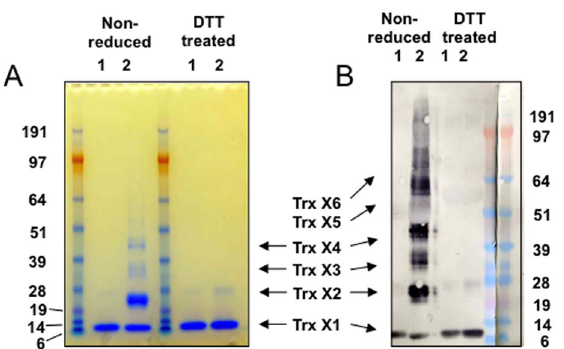
Figure 1. SDS-PAGE and Western blot analysis of recombinant human Trx1. A) SDS-PAGE analysis: Lanes were loaded with 5 m g of Trx1 from R&D (1) or Trx1 from IMCO (2). Trx1 samples to the right had first been treated with DTT for 30 min. The samples were